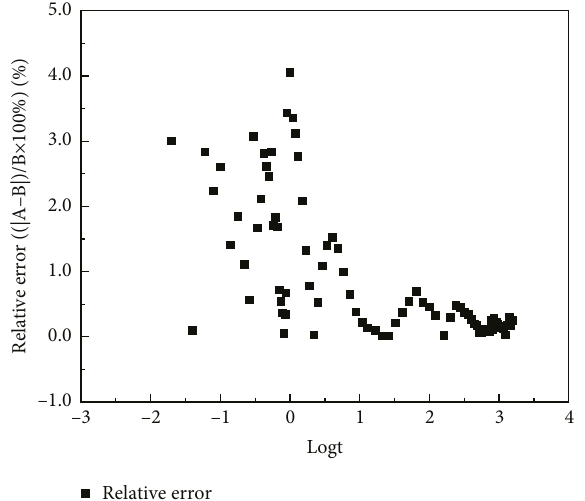
Figure 10: Relative error of data fitting under ramp-constant